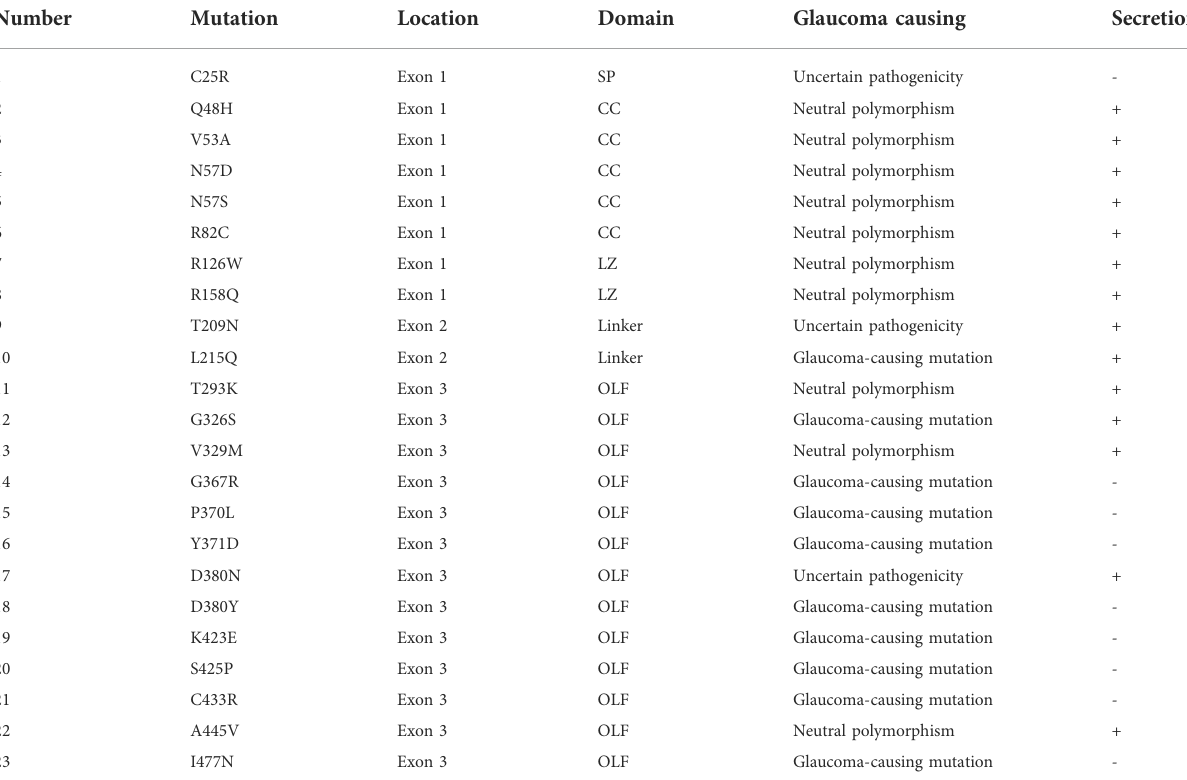
TABLE 1 Localization, pathogenicity and secretion characteristics of 23 MYOC